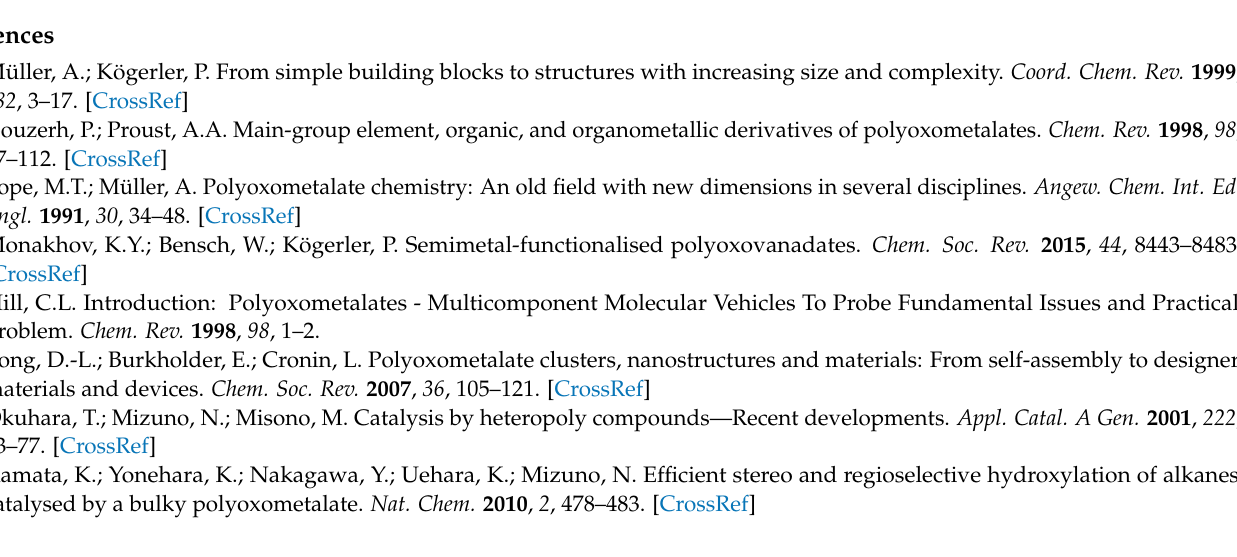
Figure S2: ORTEP plots of the [M(en) 3 ] 2+ complexes in the structures of I, II, and III with labelling. Table S1. Selected bond lengths (Å) and angles ( ◦ ) for the M 2+ coordination in I, II, and III. Table S2. Selected bond lengths (Å) and angles ( ◦ ) for the [V 6 As 8 O 26 ] 4 − anion in I. Table S3. Selected bond lengths (Å) and angles ( ◦ ) for the [V 6 As 8 O 26 ] 4 − anion in II. Table S4. Selected bond lengths (Å) and angles ( ◦ ) for the [V 6 As 8 O 26 ] 4 − anion in III. Table S5. Hydrogen bonds [Å and ◦ ] for I. Table S6. Hydrogen bonds [Å and ◦ ] for II. Table S7. Hydrogen bonds [Å and ◦ ] for